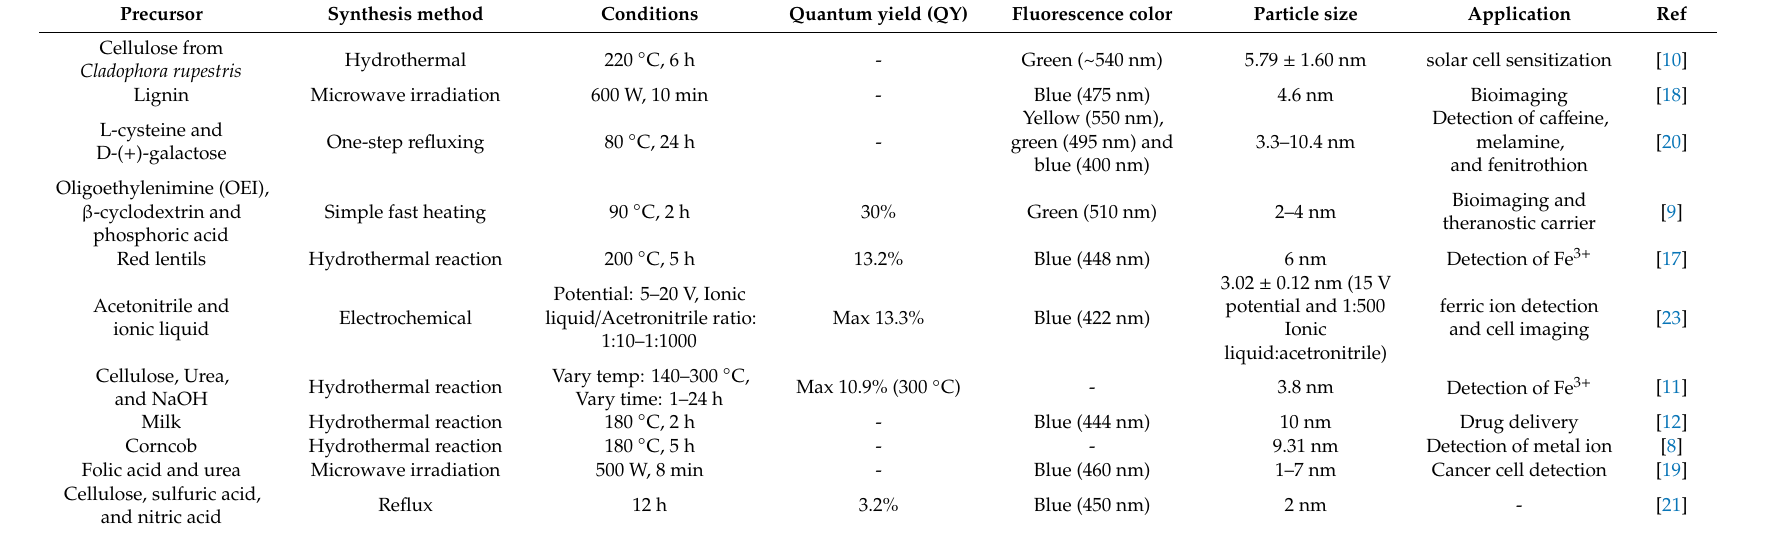
Table 1. Summary of precursors, synthesis methods, particle size, and optical properties, as well as applications of synthesized carbon